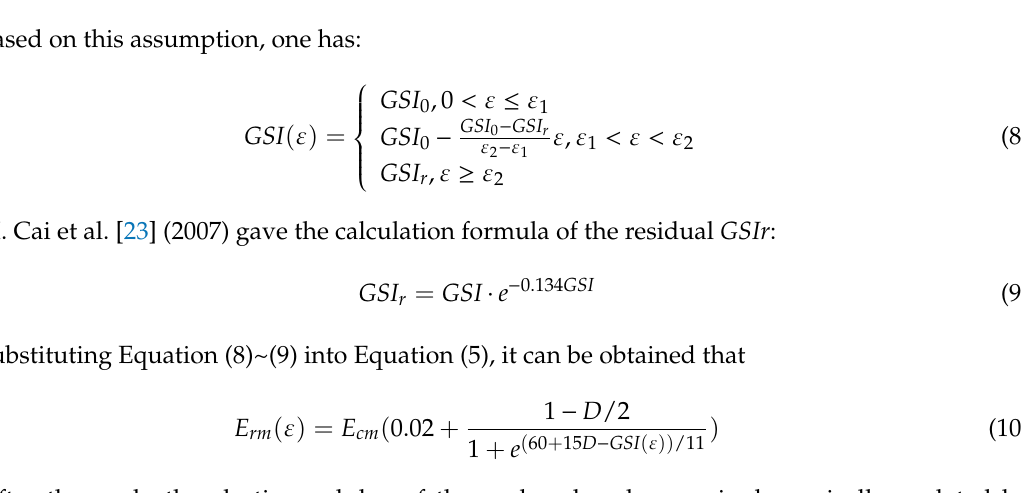
Figure 7. Relationship between Geological Strength Index (GSI) and